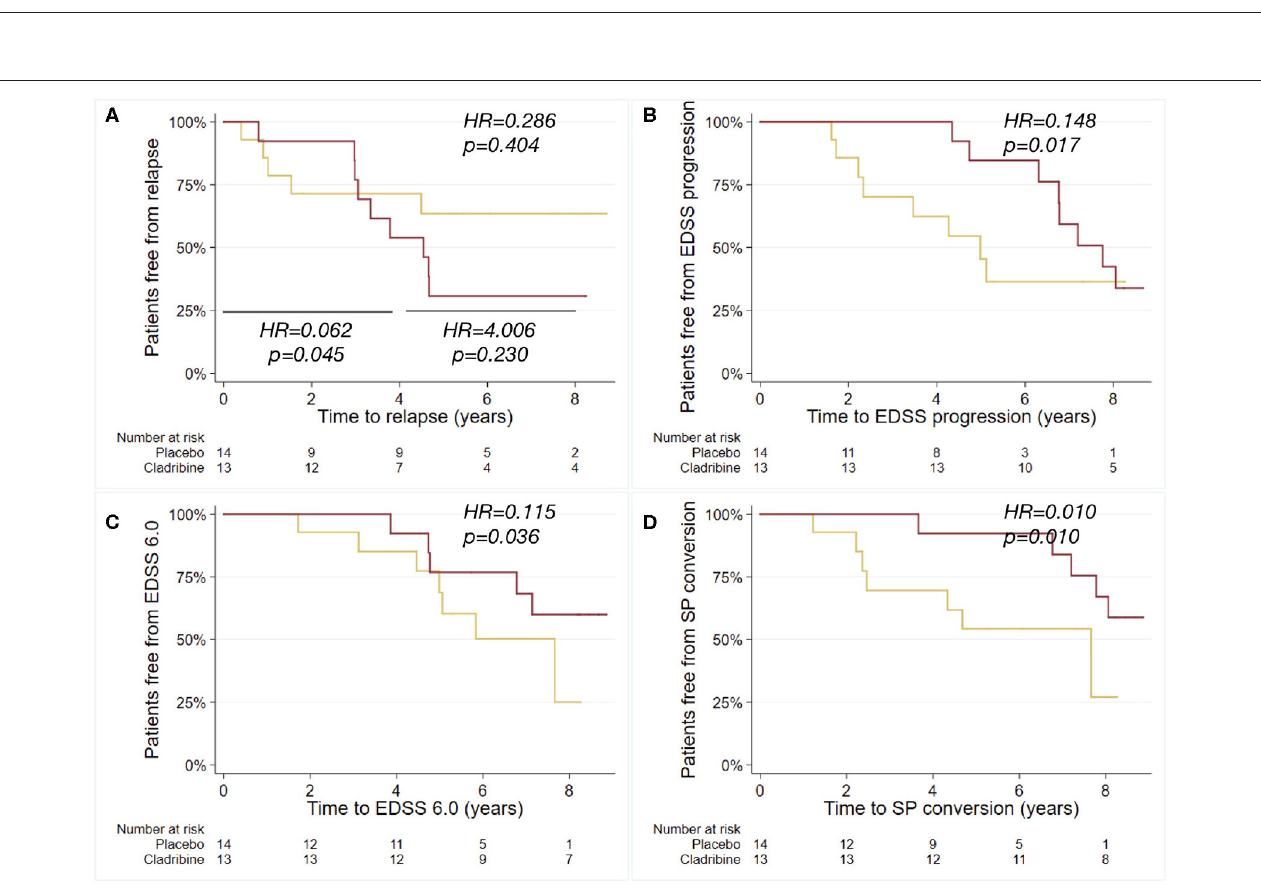
FIGURE 2 | Kaplan-Meier curves for the probability of relapse, EDSS progression, reaching EDSS 6.0 and SP conversion. Kaplan-Meier plots estimating the probability of relapse after trial termination (further sub-analyzed from baseline to year 4, and from year 4 to year 8) (A) , of EDSS progression (B) , of reaching EDSS 6.0 (C) , and of SP conversion (D) , in relation to the exposure to cladribine (red) or placebo (yellow) during the 2-years trial duration. Hazard ratios (HR) and p -values are shown from Cox regression models.